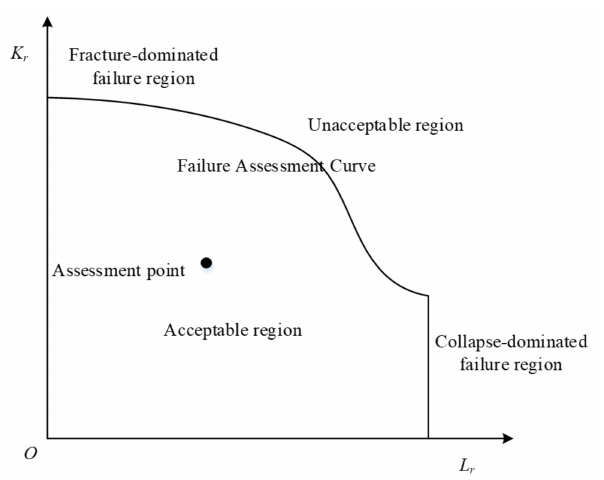
Figure 1. Schematic of the